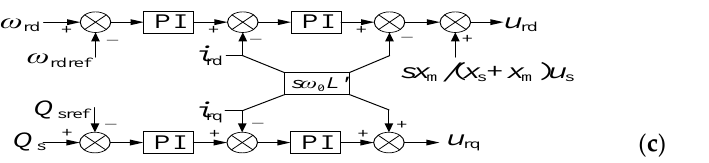
Figure 2. The topology and control system of a DFIG: ( a ) topology structure; ( b ) control strategy of the grid-side converter (GSC); ( c ) control strategy of the rotor-side converter (RSC). The mathematical model of the DFIG, as shown in [24], is linearized at the equilibrium point to obtain the linearized model shown in Equation (1). (cid:26) ∆ . x DFIGs = A DFIGs ∆ x DFIGs + B DFIGs ∆ u